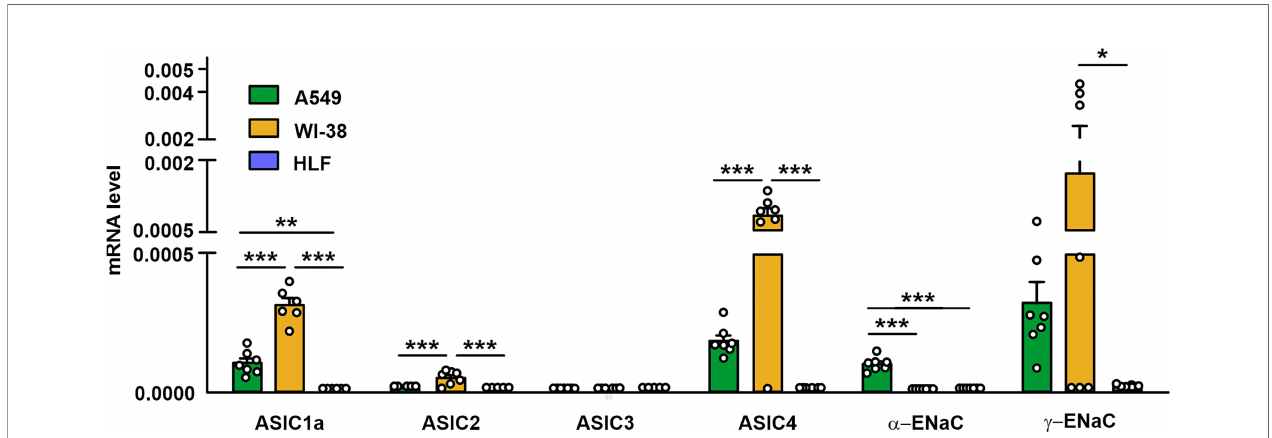
FIGURE 4 | qPCR analysis of the ACCN2 , ACCN1 , ACCN3 , ACCN4 , SCNN1A , and SCNN1G expression in A549, WI-38, and HLF cells. Gene expression was normalized to the b -ACTIN , GPDH , and RPL13a housekeeping genes and presented as relative mRNA level ± SEM (n = 6). * (p < 0.05), ** (p < 0.01), and *** (p < 0.001) indicate signi fi cant difference between the data groups according to one-way ANOVA followed Tukey ’ s post-hoc test, n.s. - no signi fi cant